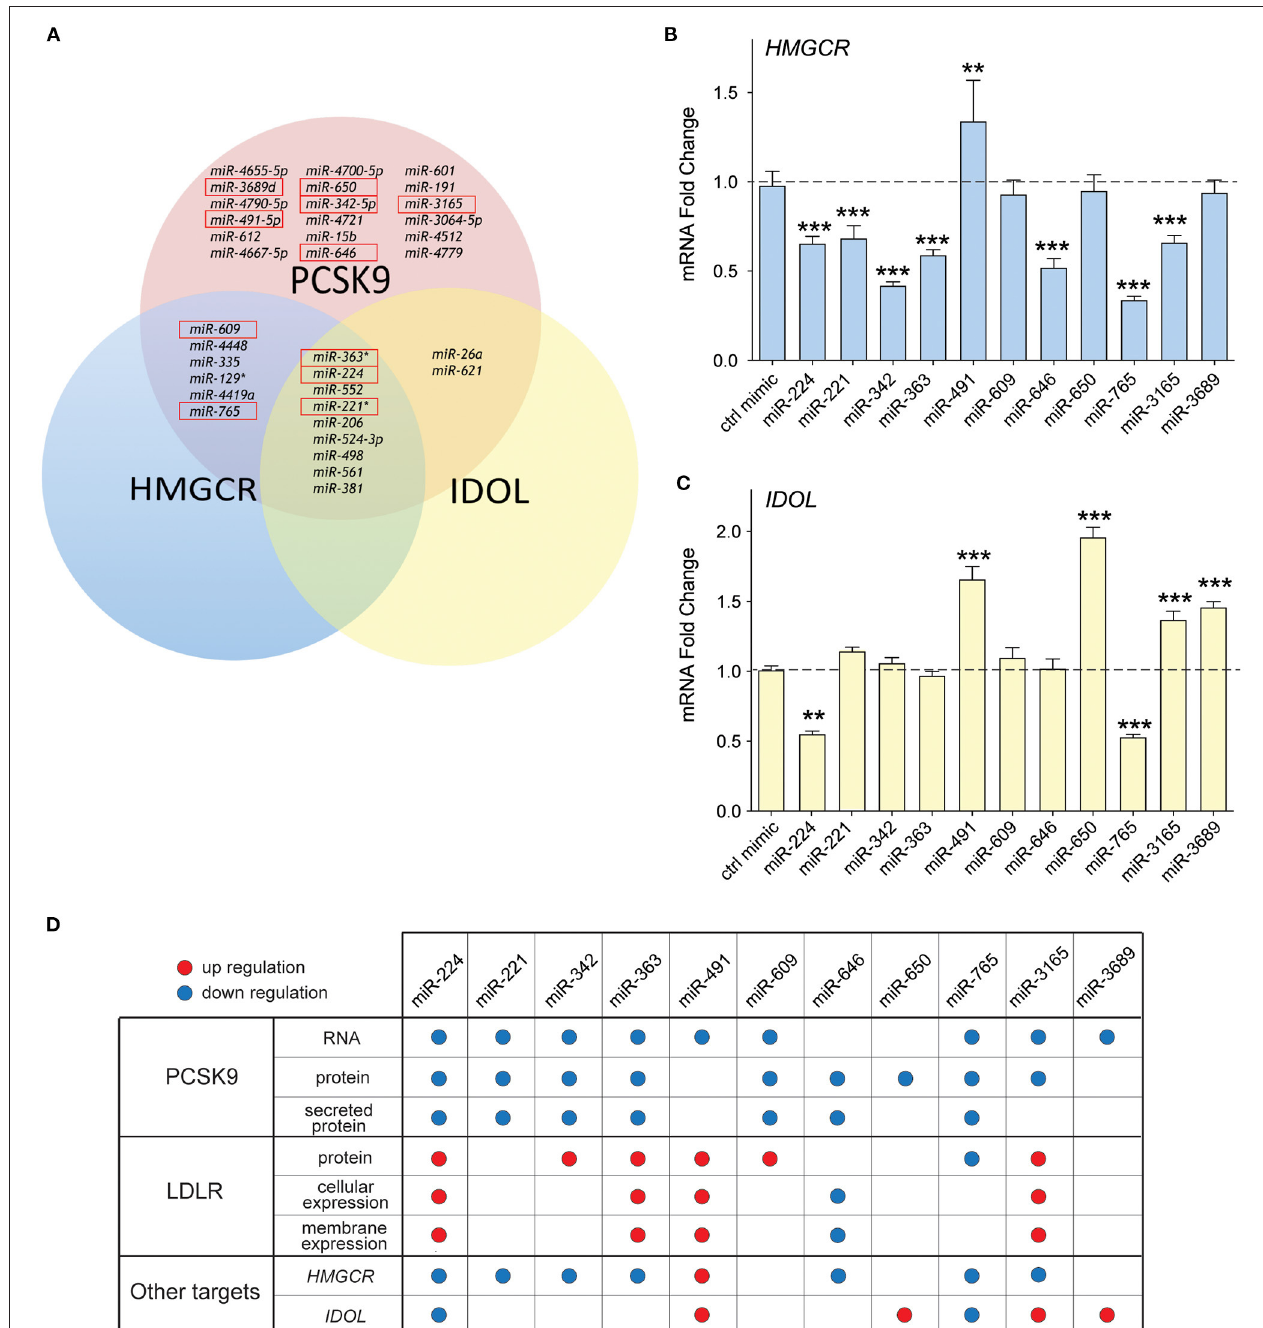
FIGURE 6 | Common targeting of genes involved in low-density lipoprotein (LDL) receptor regulation by candidate miRNAs. (A) Venn diagram of the top 35 miRNAs identified to repress PCSK9 showing overlapping targeting of HMGCR and IDOL . The top 10 miRNAs validated for PCSK9 targeting are shown in the red boxes. (B,C)